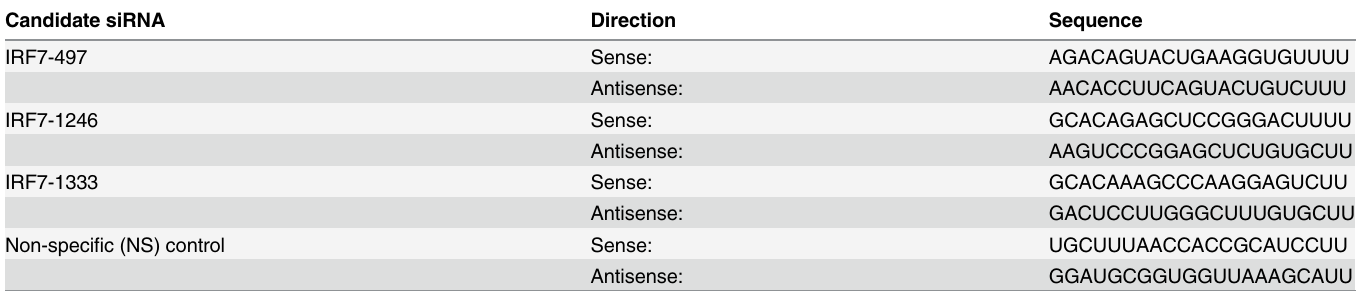
Table 2. Information of IRF7 knockdown